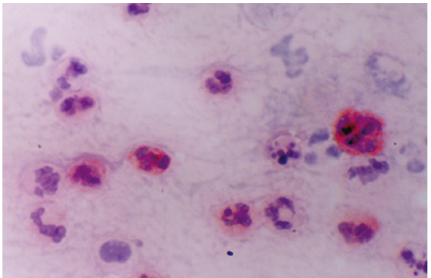
Figure 2: Periodic acid Schi ff (PAS) staining of the aspirated fluid. The blue staining indicates that the fluid is saliva and confirms the diagnosis of mucocele. Note the presence of the inflammatory cells ( × 400).